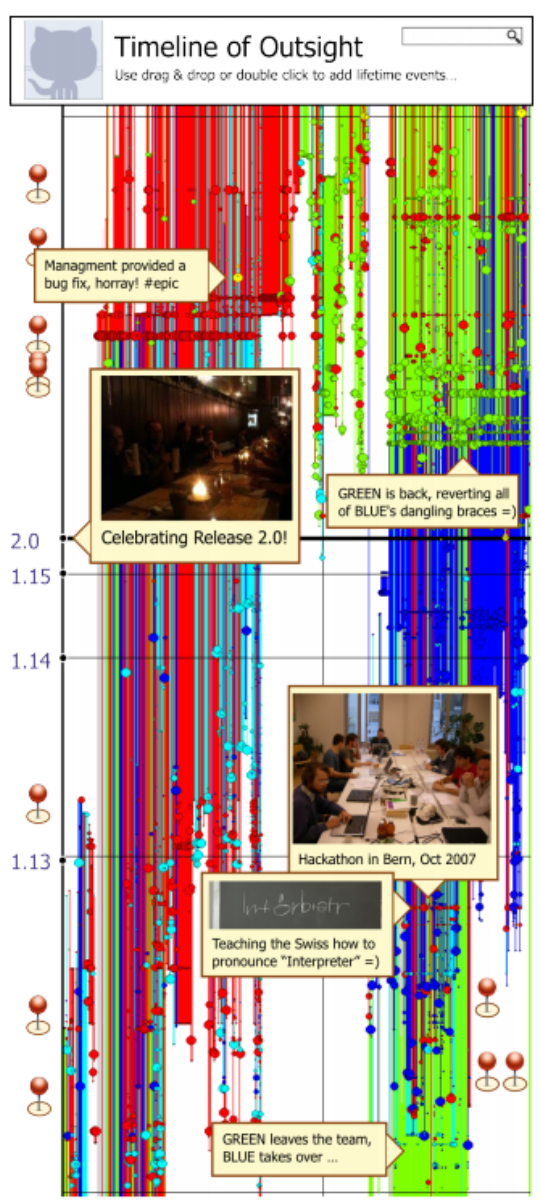
Figure 11. Kuhn and Stocker show the CodeTimeline collaboration view. Colors denote different user contributions and each line represents the life of files in the code. Sticky notes are added so the users can learn the history of the code beyond the file evolution [27]. Image courtesy of Kuhn and Stocker